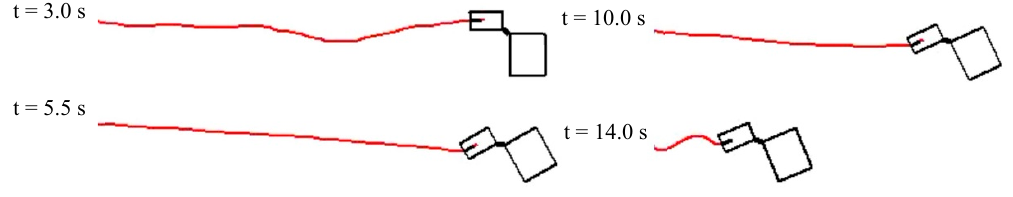
Figure 20. Shape of the system during tether winding (control 1).